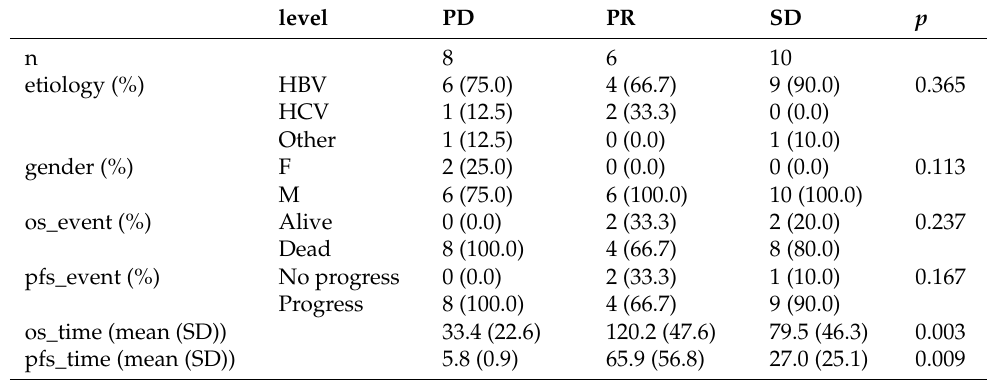
Table 2. Patients PD, PR and SD back ground for GSE140901.